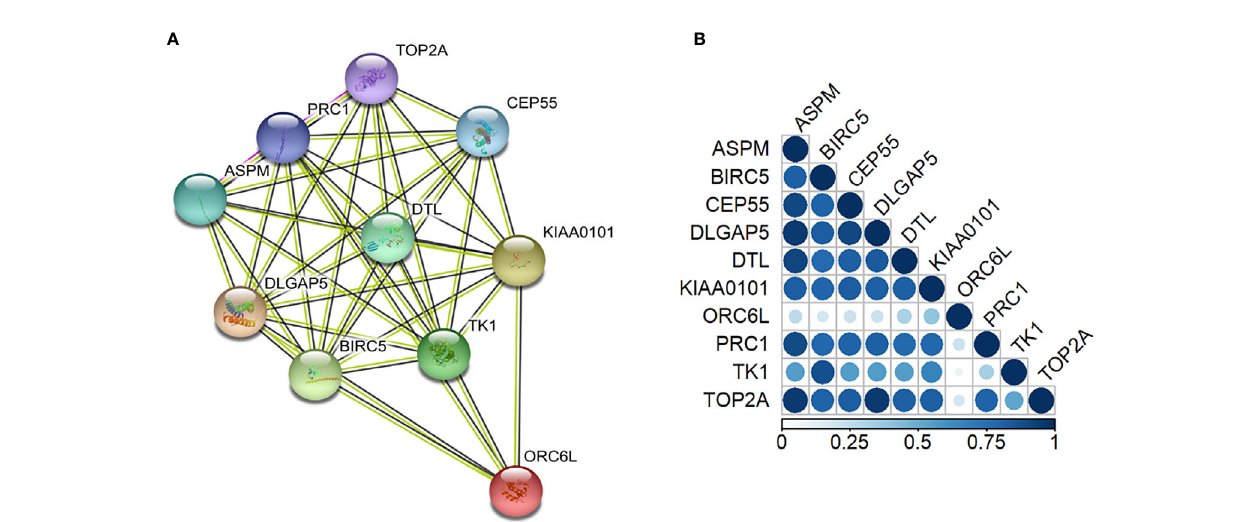
FIGURE 4 | Protein annotations of genes with differential relative mRNA expression in early- and advanced-stage non-small cell lung cancer stem cells. (A) STRING diagram representing a protein interaction pathway derived from 10 genes identi fi ed as overexpressed in lung CSCs (https://string-db.org/). The network was made by 41 edges with a protein-protein interaction enrichment p-value < 0.0001. (B) Gene co-expression analysis revealed that in Homo Sapiens, all the genes were highly co-expressed except for the ORC6L gene. In the triangle matrix, the color indicates the level of co-expression of pairs of proteins in Homo sapiens. The co- regulation map can be explored at www.proteomeHD.net.